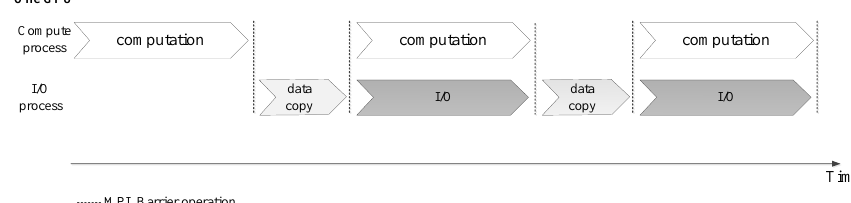
Figure 8. One computing process and one I / O process both set their contexts on the same GPU. During the data copy phase, the computing process remains idle and the I / O process will copy data from the GPU to the CPU through the cudaMemcpy function.